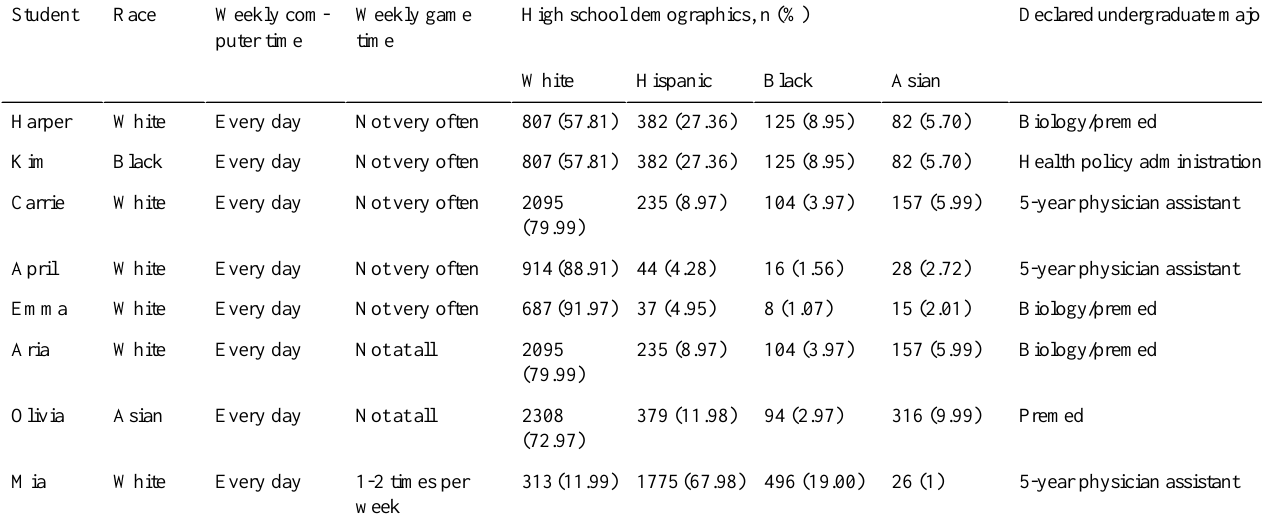
Table 1. Participant